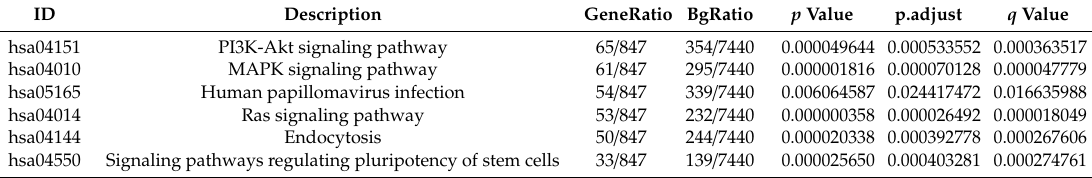
Table 3. Predicted pathways associated with the identified miRs in nephrotic DN patients.